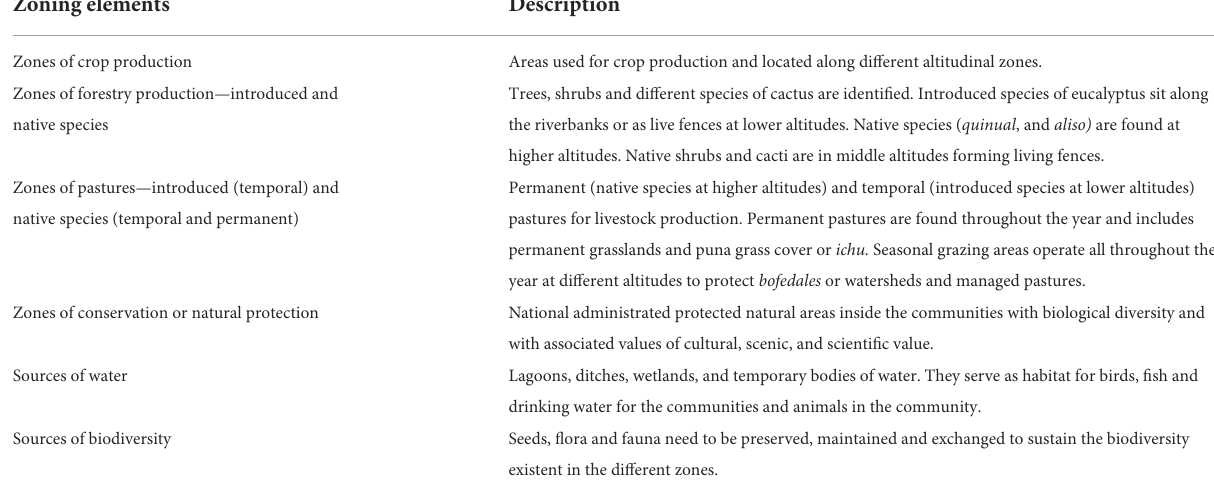
TABLE 4 Main elements of communal zoning. Zoning elements